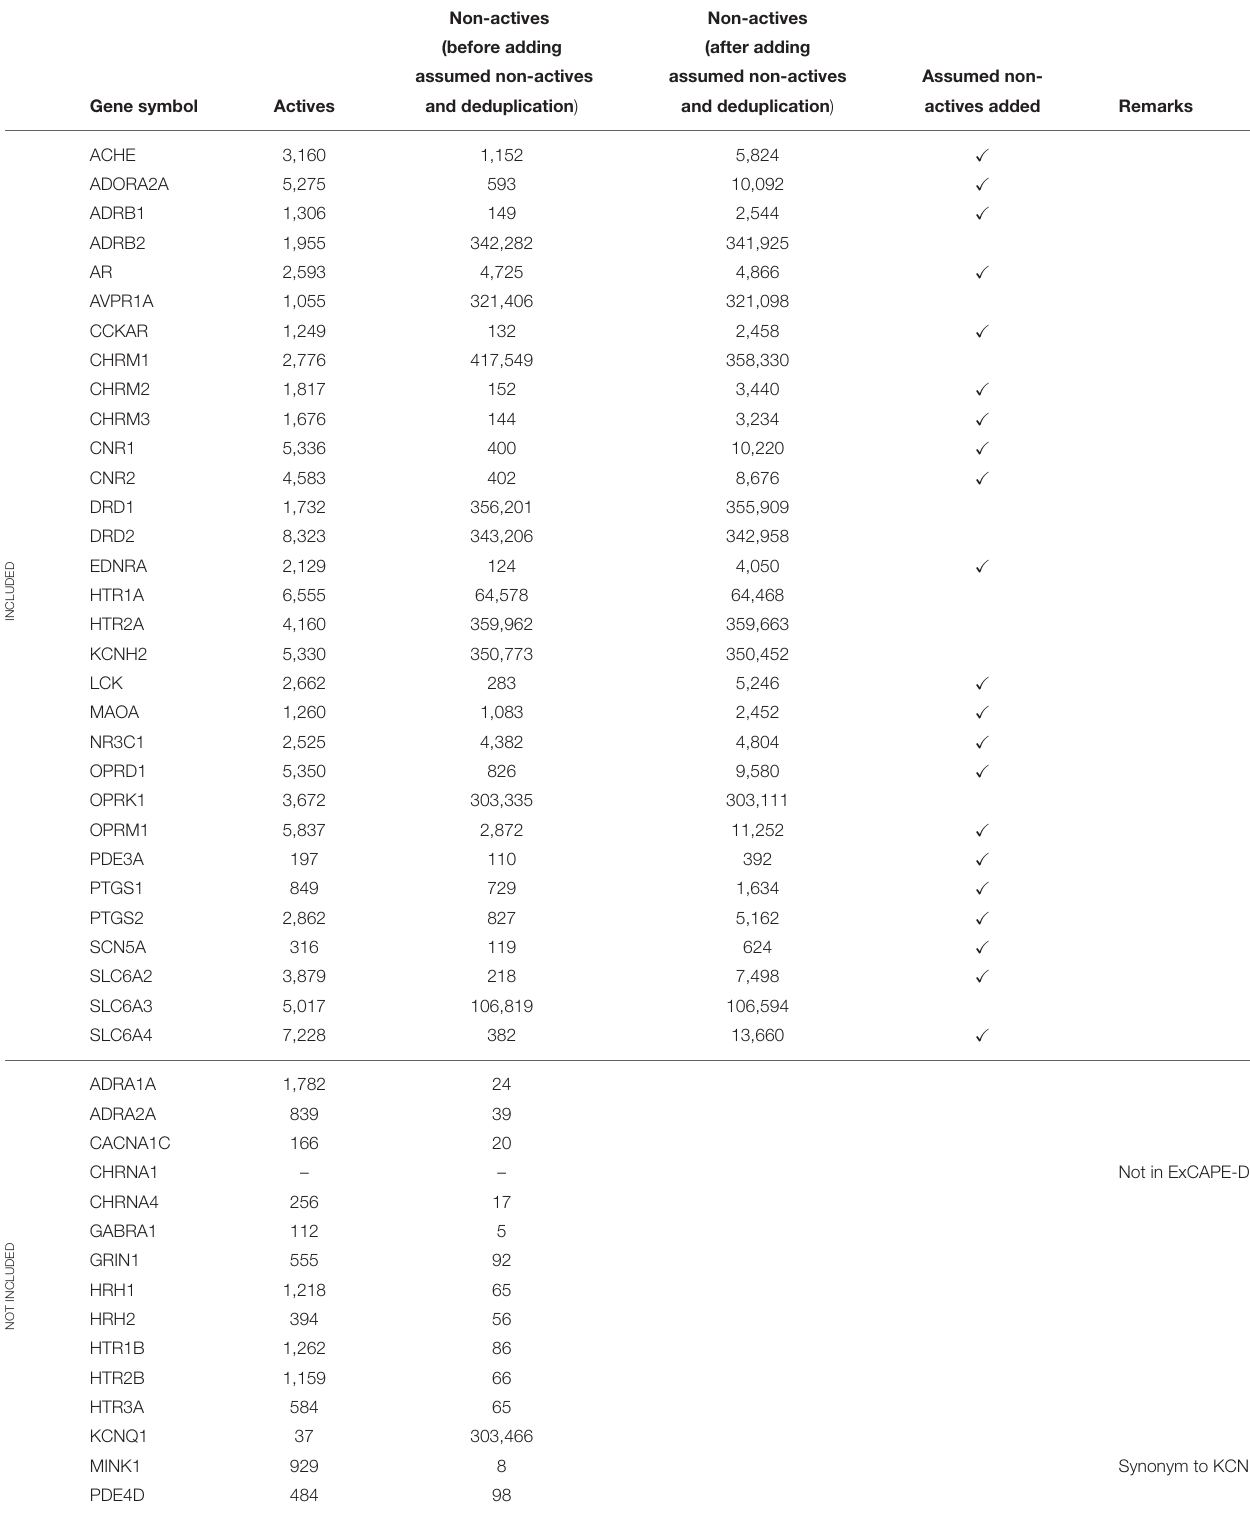
TABLE 1 | The panel of targets used in this study, identified by gene symbol. Non-actives Non-actives (before adding (after adding assumed non-actives assumed non-actives Assumed